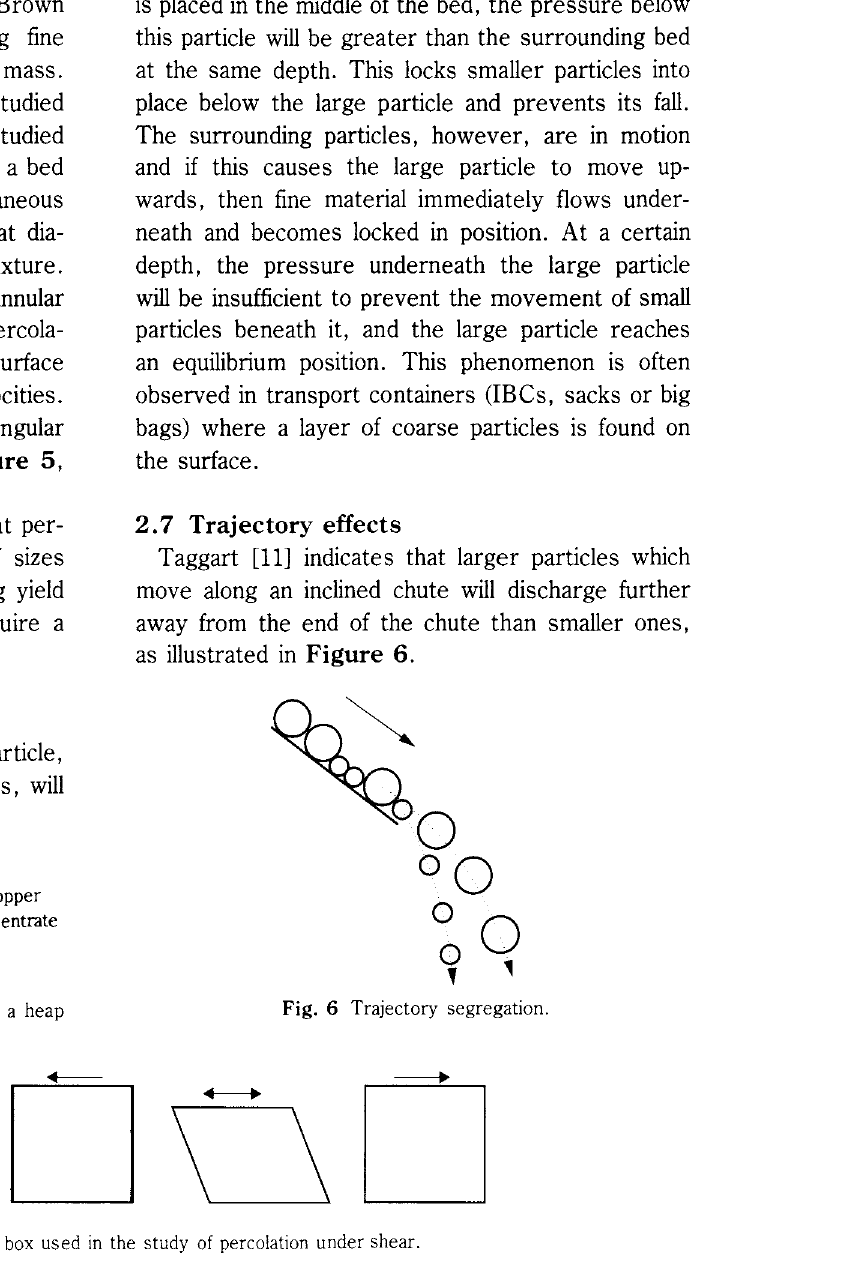
Fig. 5 Principle of shear box used in the study of percolation under shear. KONA No.l4